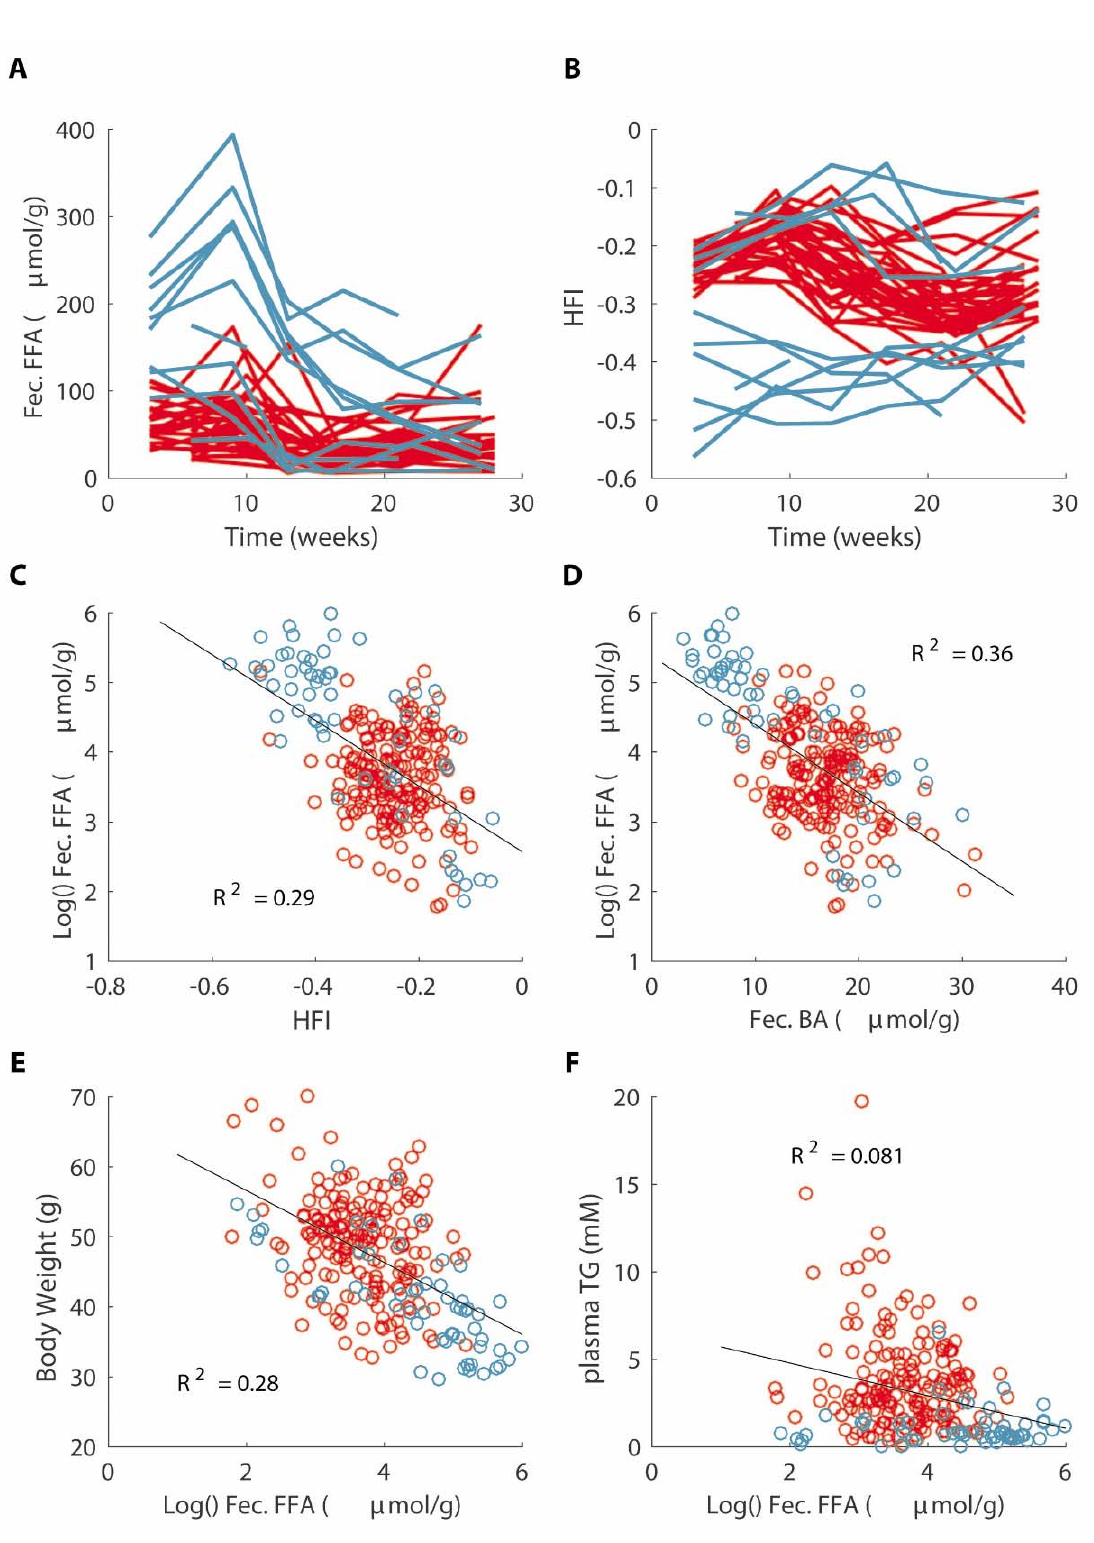
Figure 6. Fecal fatty acid excretion (Fec. FFA) ( A ) and hydrophobicity index (HFI) of fecal bile acids ( B ) over time. Correlations between fecal fatty acid excretion and HFI ( C ), fecal bile acids (Fec. BA) ( D ), body weight ( E ) and plasma TG ( F ). Responders are marked in red and non-responders are marked in blue.